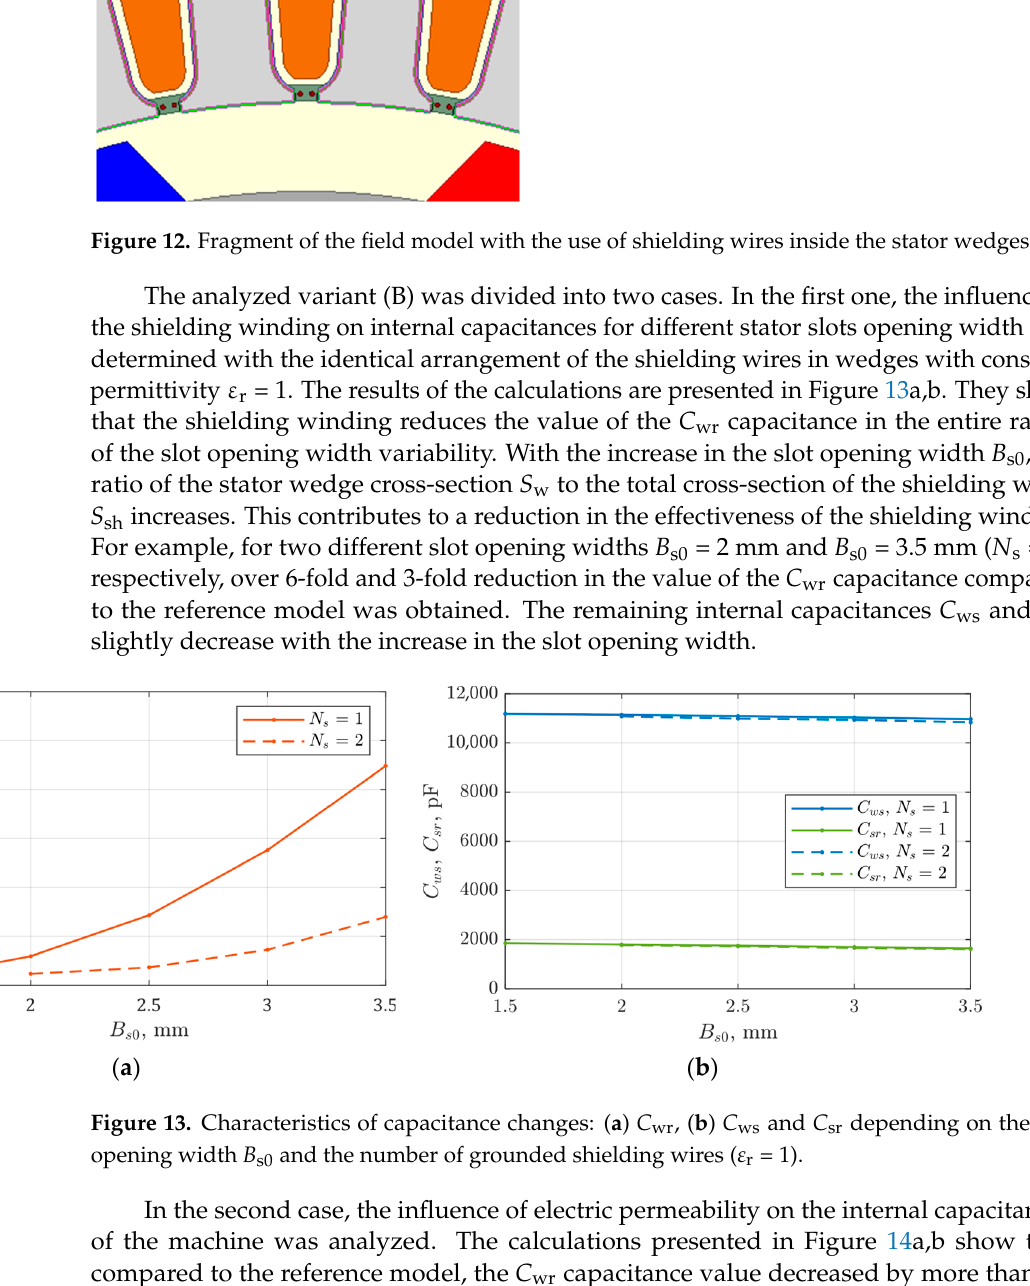
( b ) Figure 14. Characteristics of capacitance changes: ( a ) C wr , ( b ) C ws and C sr depending on the value of the electric permeability of the wedge closing the slot and the number of grounded shielding wires. ( B s0 = 2 mm).